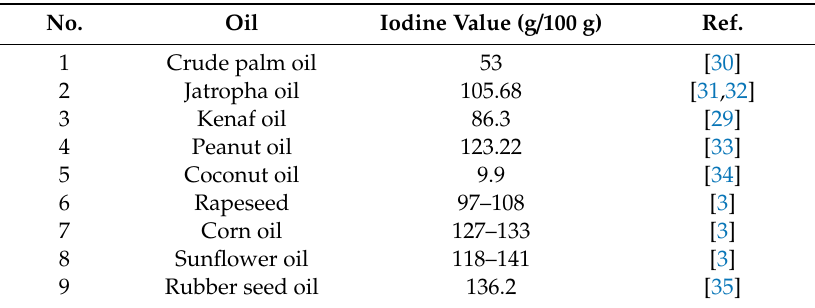
Table 6. List of iodine values for several vegetable oils.